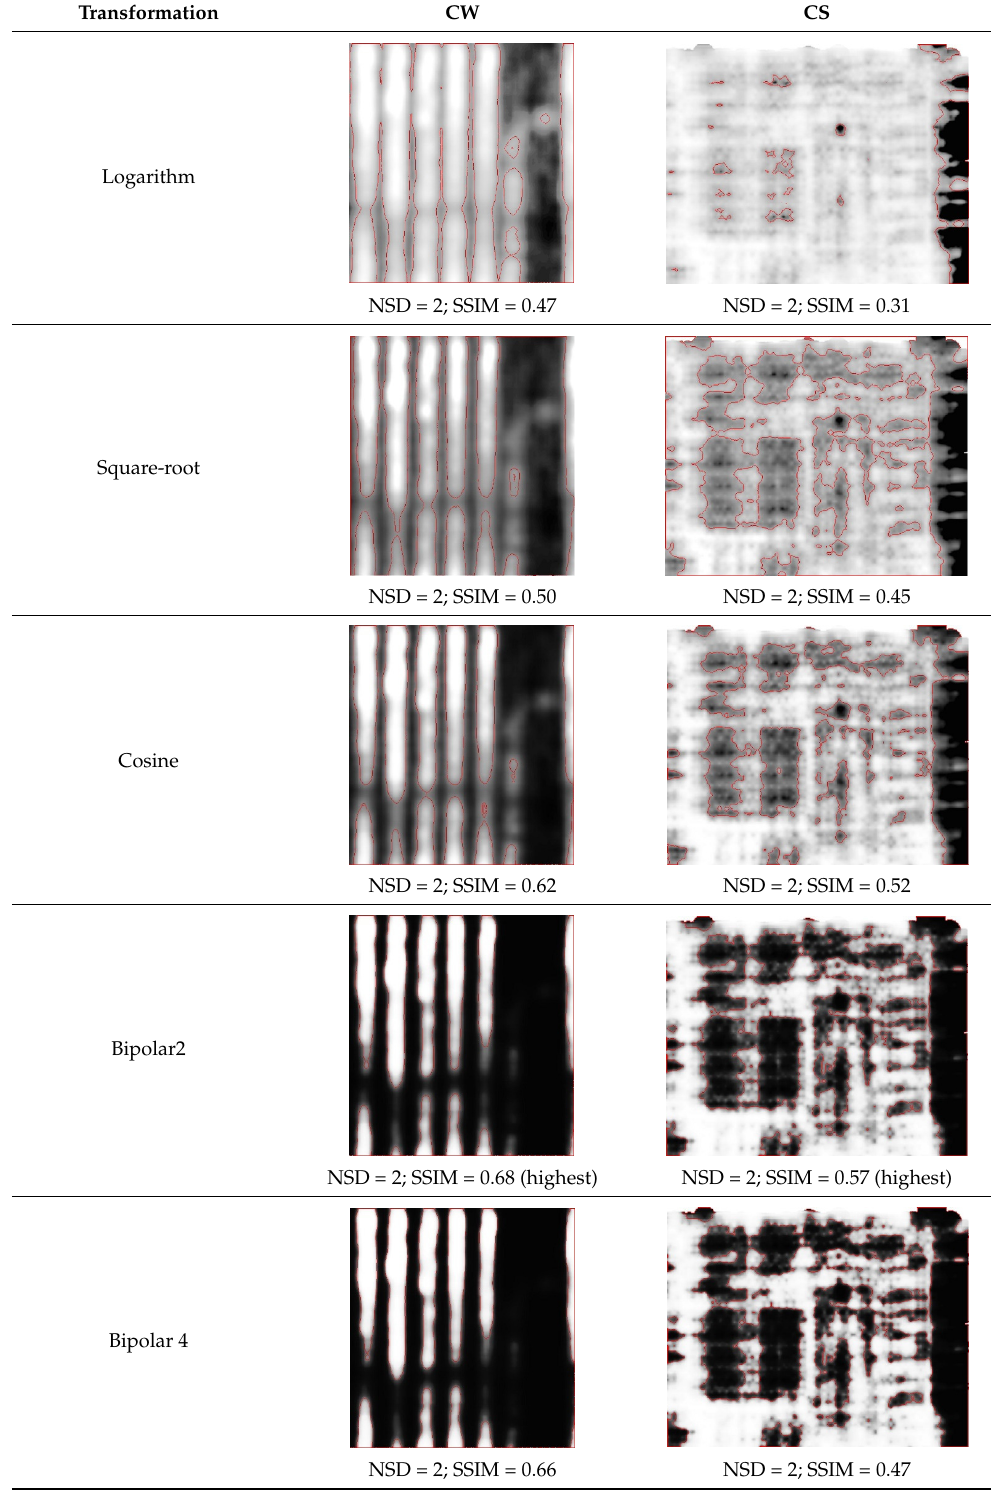
Table 4. Visualisation results of reinforced concrete structures cases with different transformations.